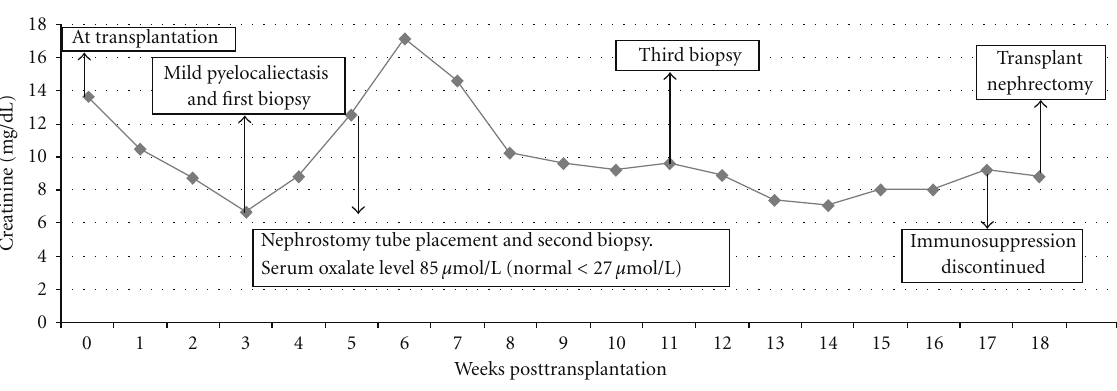
Figure 1: Serum creatinine levels and related events during the course of renal transplantation.